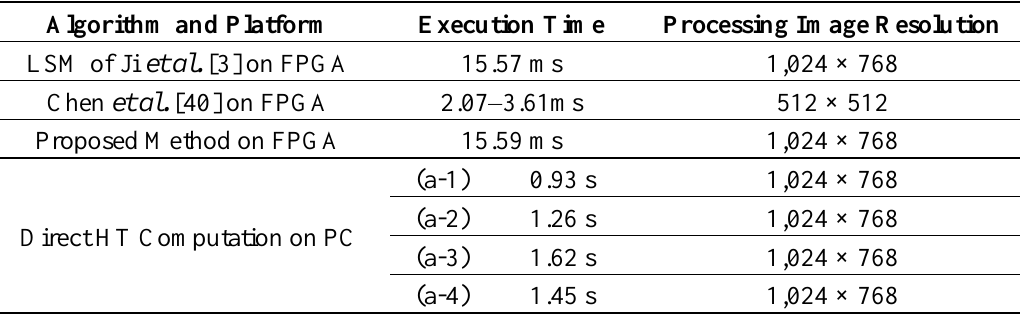
Table 3. Calculation time